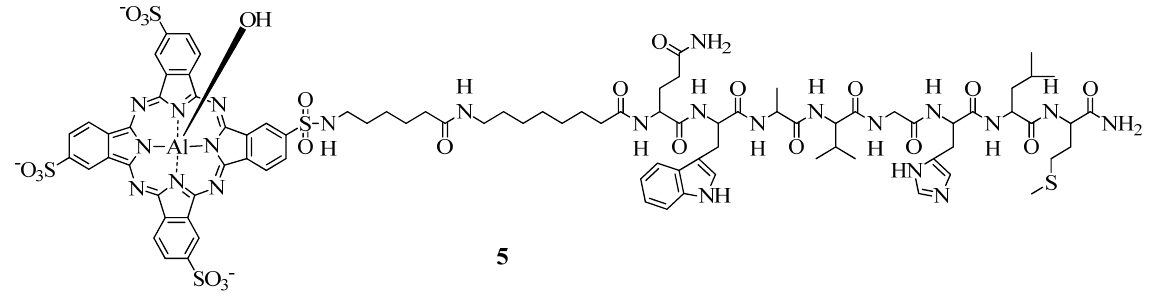
Figure 4. Chemical structure of the bombesin-AlPcS